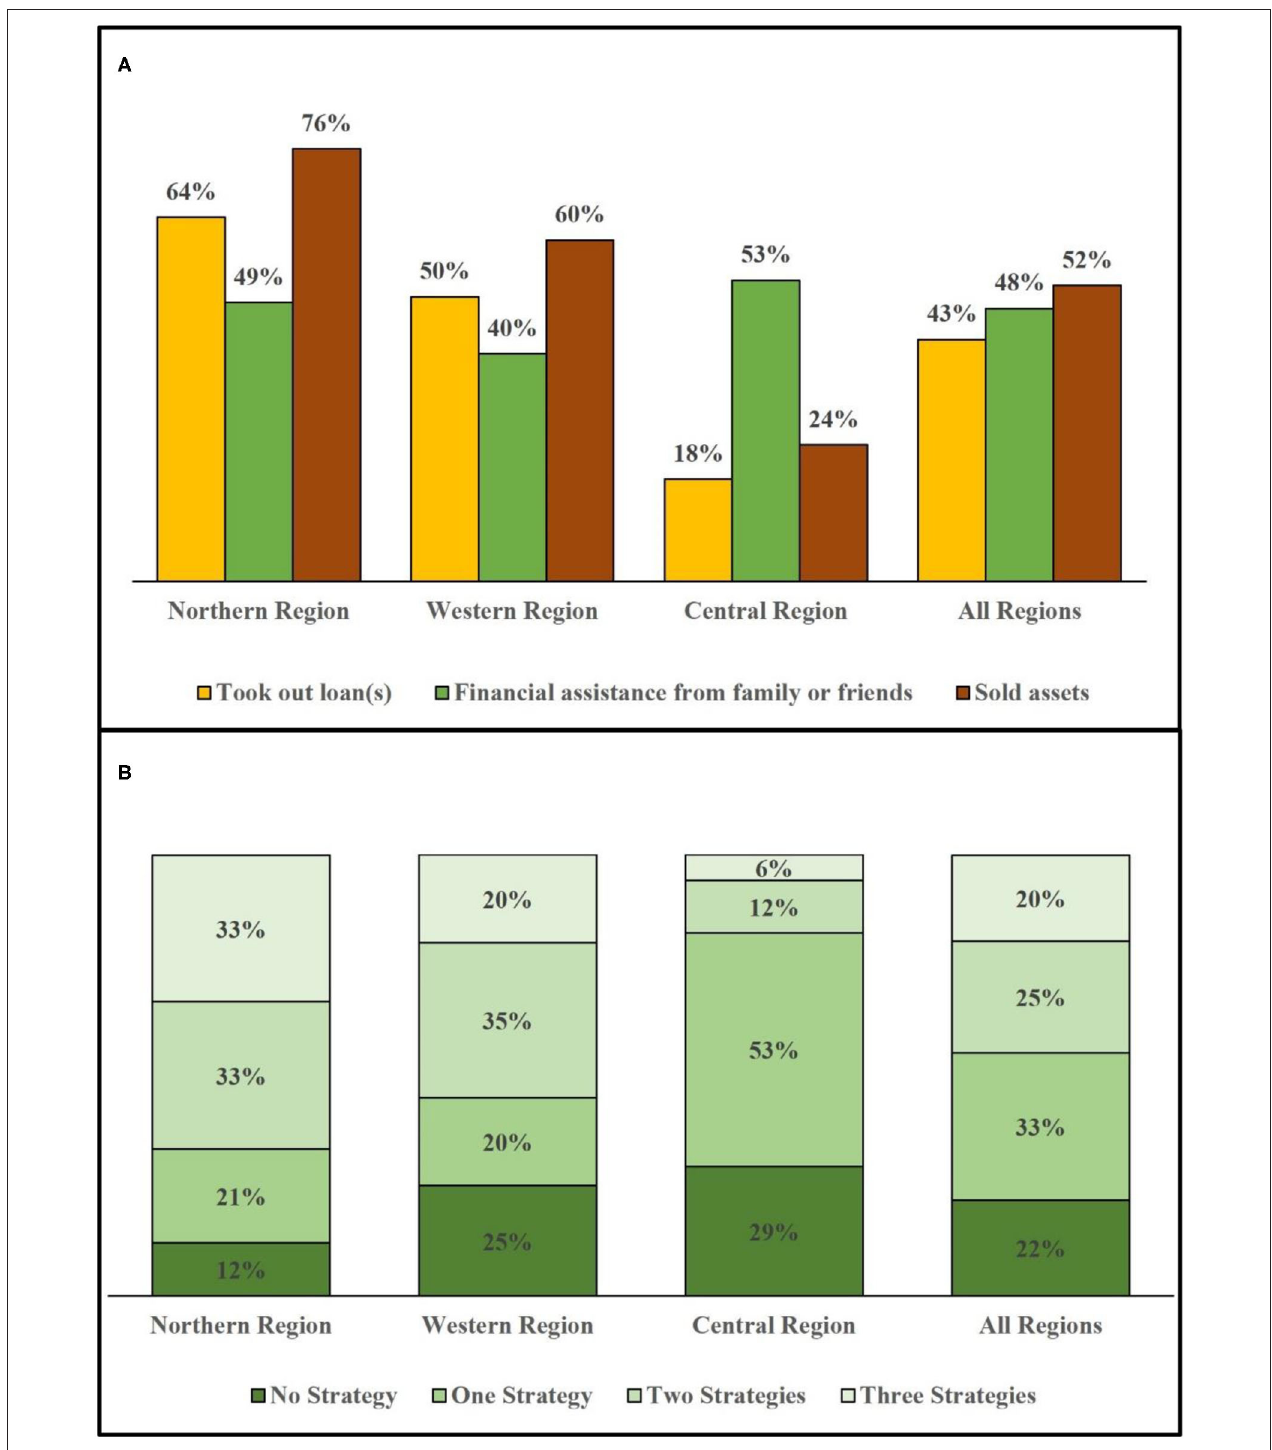
FIGURE 3 | Utilization of financial coping strategies by region. The bar graphs show distribution of financial coping strategies used by households across regions ( n = 87). This represents the 33 households in the Northern Region, 20 households in the Western Region, and 34 households in the Central Region that were sampled in this study. (A) Frequency of each of three coping strategies used. (B) Reliance on zero, one, two, or all three coping strategies. Note: Due to rounding, the sum for the Northern region adds to 99%, and the actual number with more decimal points adds to 100%.